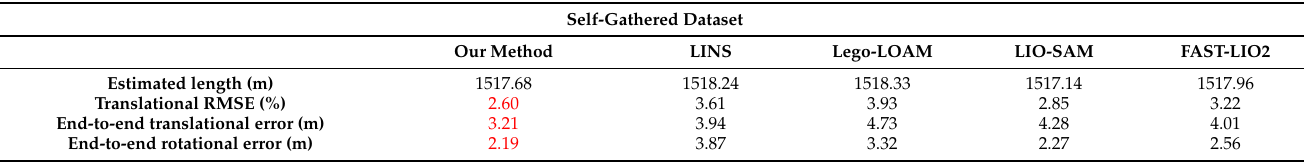
Table 2. Accuracy evaluation of the trajectories estimated by different methods and LIO systems in self-gathered